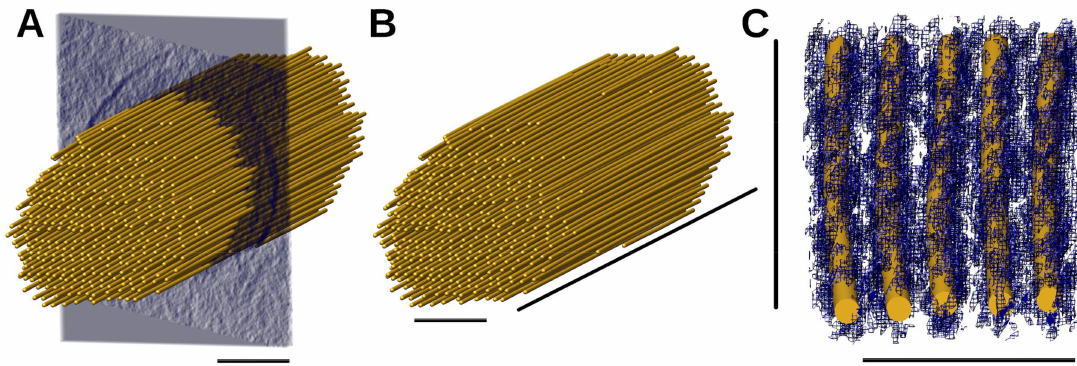
Figure 3. The model of actin filaments, manually constructed as ground-truth. ( A ) Model of stereocilium with cross-sectional slab about 30 nm thick. The scale bar is 100 nm; ( B ) model of stereocilium. The horizontal scale bar is 100 nm, and the diagonal scale bar is 1080 nm; ( C ) local actin filaments of the model superimposed onto the actin densities. The horizontal scale bar is 50 nm, and the vertical scale bar is 540